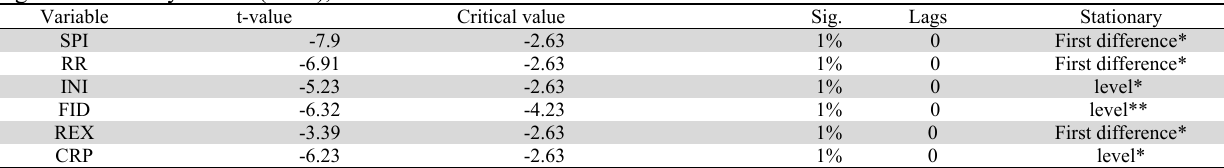
Augmented Dickey–Fuller (ADF), Unit Root